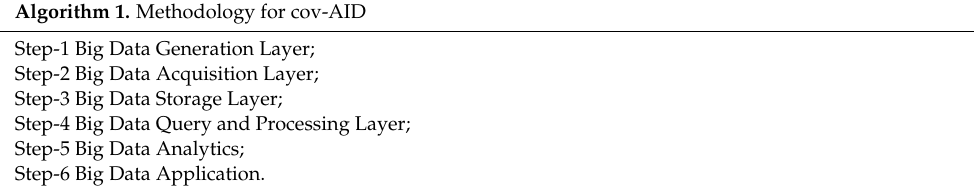
Algorithm 1. Methodology for